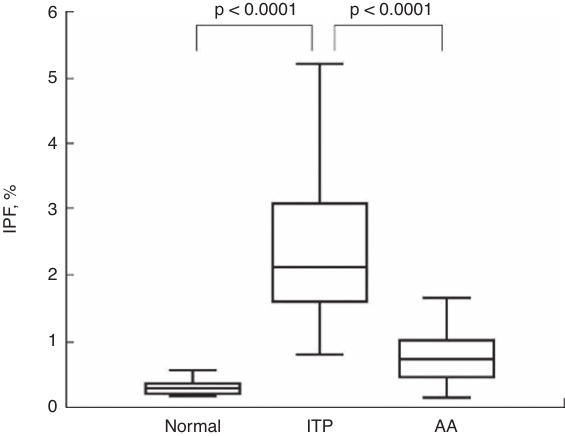
Figure 2: Immature platelet fraction in healthy individuals and patients with aplastic anemia [22].